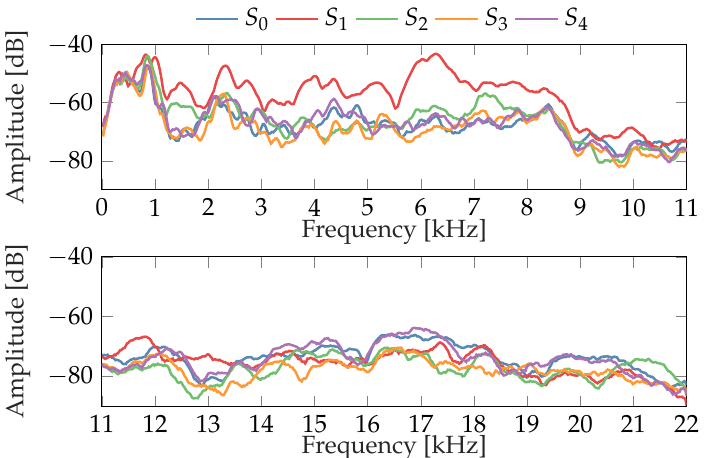
Figure 11. Averaged frequency spectra of the measurement series of the gearbox with damage to gear z 1 .